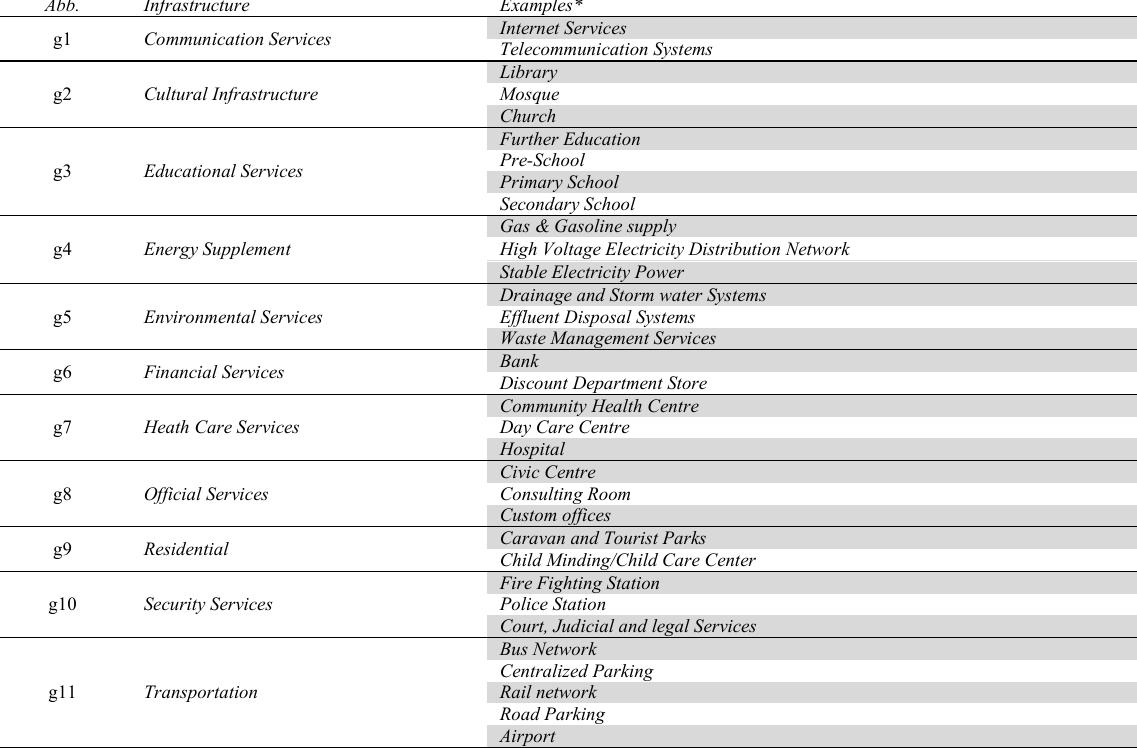
Infrastructure of investment, the fifth port of Asia and the Pacific